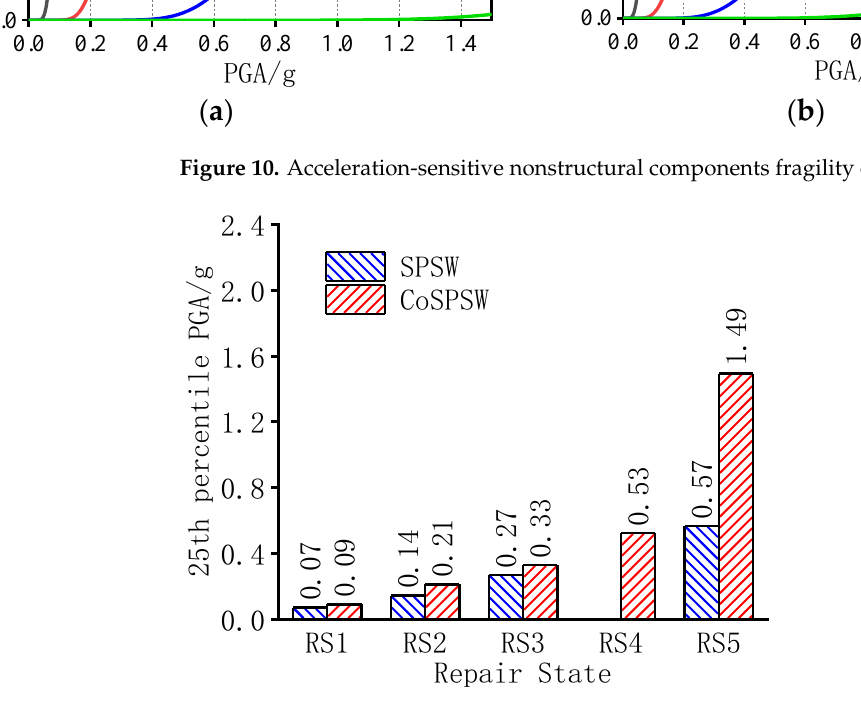
Figure 11. The 25th percentile PGA from structural fragility curves.